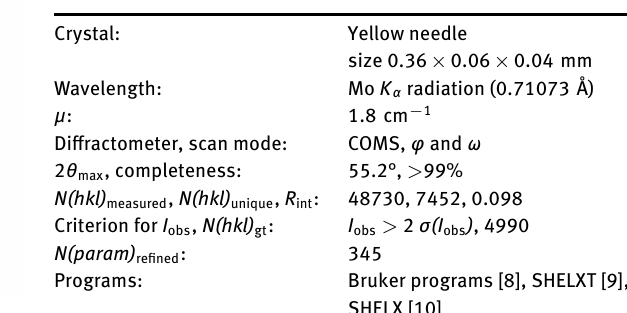
Table 1: Data collection and handling.